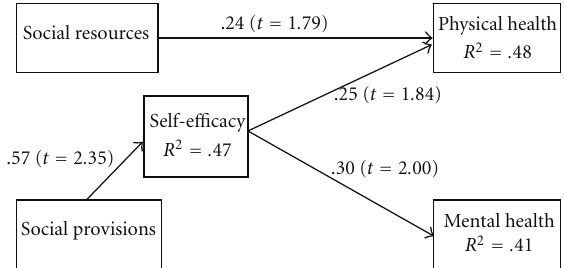
Figure 3: Test results for the support-e ffi cacy model with centenar- ians residing in assisted living facilities; model fit: Satorra-Bentler χ 2 ( N = 55; df = 4) = 5.29; P = . 26; CFI = . 97; RMSEA = . 08; SRMR = . 04 (using F1ML). Parameter estimates are from the standardized solution; endogenous variables were controlled for sex, mental status, ADLs, education, and economic su ffi